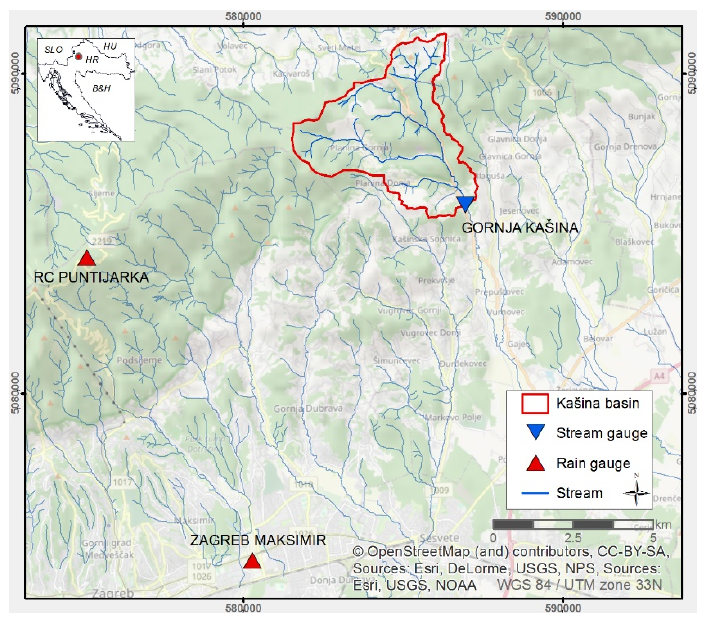
Figure 1. The location of the Kašina Basin margins, “Gornja Kašina” stream gauge, rain gauges and river network.